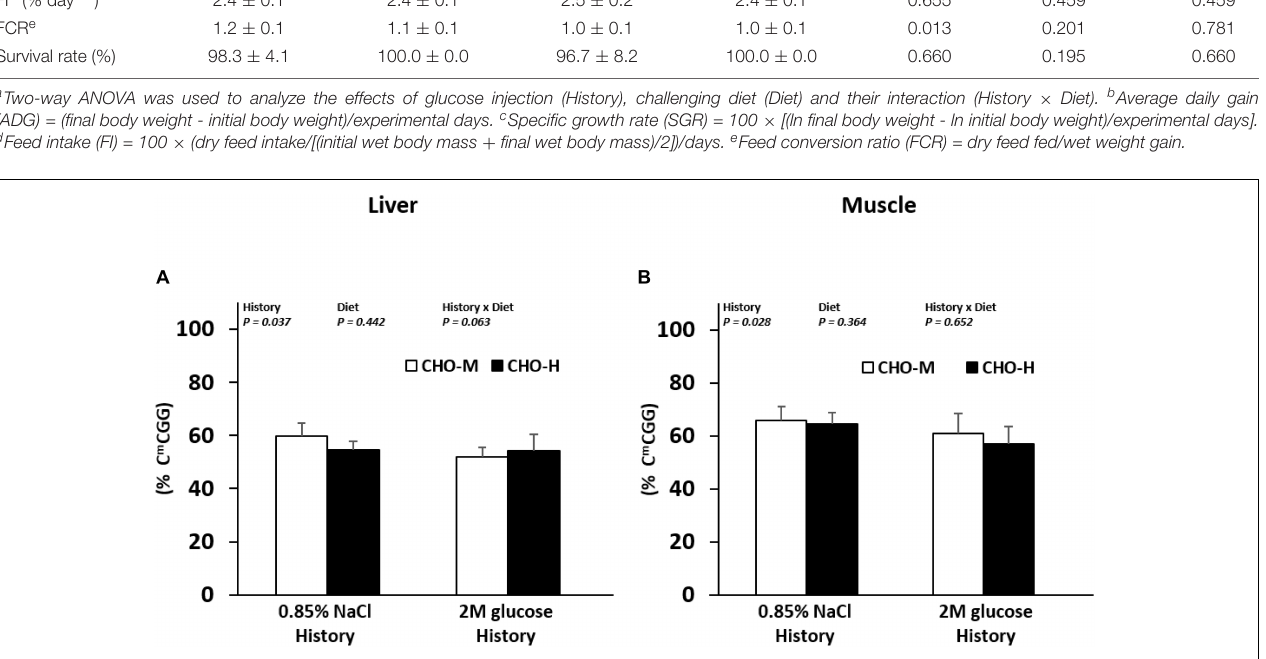
FIGURE 5 | Effects of the glucose injection history and dietary carbohydrate challenge on the global DNA methylation in Nile tilapia. The levels of 5-methylcytosine (5-mC%: 5-mC/total DNA) in the DNA in the liver (A) and muscles (B) were measured in fish challenged with different dietary carbohydrate levels (37% carbohydrates, CHO-M; 67% carbohydrates, CHO-H). Data are presented as the mean ± SD ( n = 6). Two-way ANOVA was used to analyze the effects of glucose injection (History), challenging diet (Diet) and their interaction (History ×